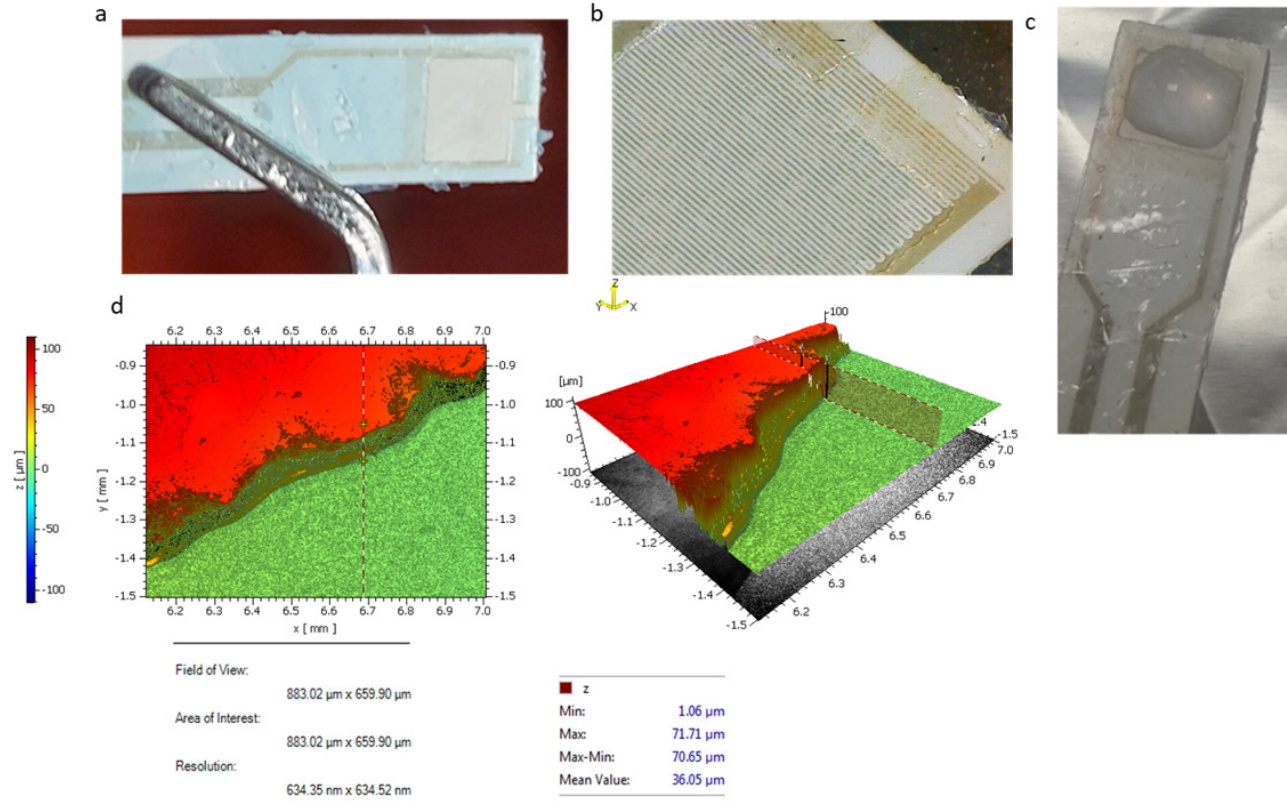
Figure 4. Patterning square-shaped wells on capacitor sensitive area: ( a ) image of the patterned well; ( b ) image of the well in 20× magnification; ( c ) a droplet is placed at the well; and ( d ) ORDYL thickness measured with optical profilometer.